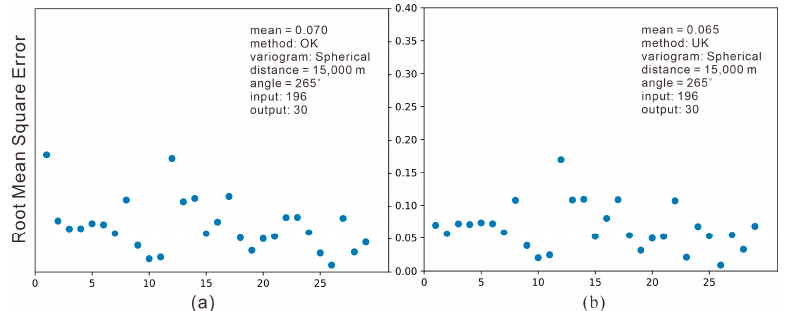
Figure A13. An additional test to compare the RMSE of different methods: ( a ) OK; and ( b ) UK. The mean RMSEs and parameters are listed in the top right-hand corner.